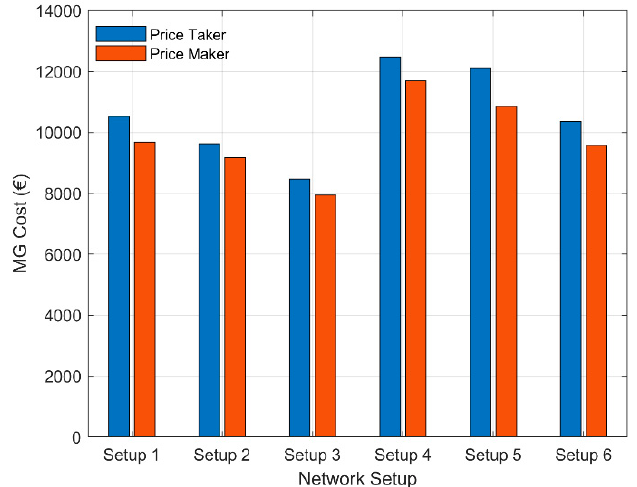
Figure 5. MGO’s costs (price taker vs. price maker bidding).